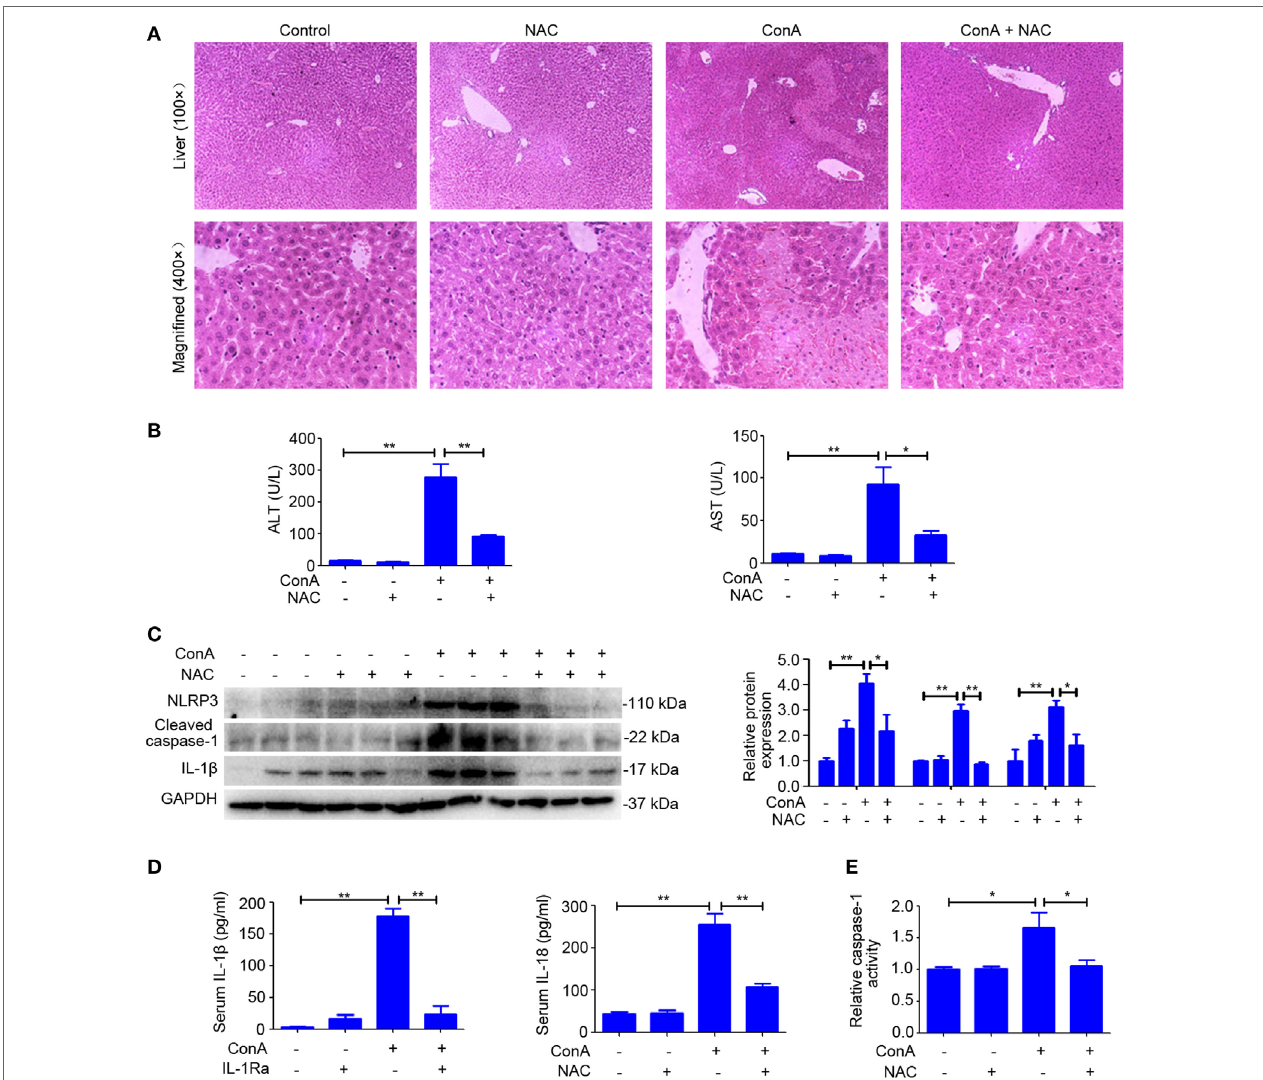
FigUre 7 | N -acetyl-cysteine (NAC) attenuated ConA-induced hepatitis via suppressing NOD-like receptor protein 3 (NLRP3) inflammasome activation. (a) BALB/c mice ( n = 6 for each group) were pretreated with NAC and subsequent exposed to ConA challenge for 12 h, then sacrificed for collecting samples. Representative hematoxylin and eosin images of liver tissues were shown (100 × , magnification: 400 × ). (B) Serum ALT and aspartate transaminase (AST) activity were assessed. (c) Western blot was performed to detect NLRP3 inflammasome-associated protein NLRP3, Cleaved caspase-1 and IL-1 β in the livers. Each lane represented a separate animal. Results shown represented three independent experiments. Quantification of protein expression with Image J software. (D) The concentrations of IL-1 β and IL-18 in serum were measured by ELISA. (e) Caspase-1 enzymatic activity in liver homogenates. The data were presented as means ± SD (Student’s t -test, * p < 0.05, ** p <